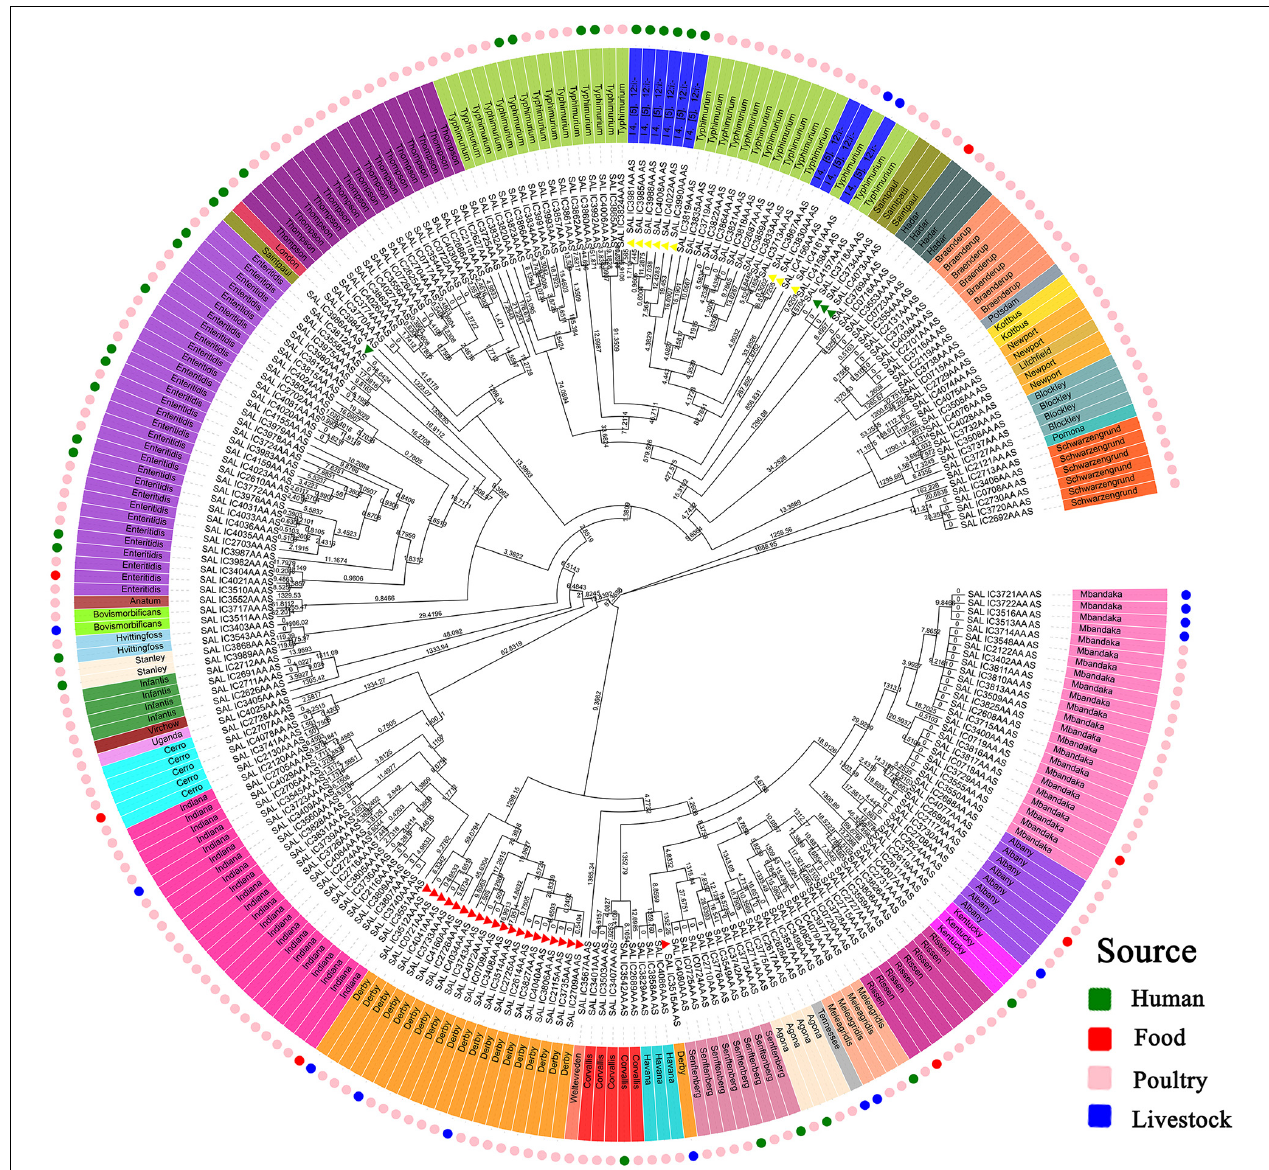
FIGURE 3 | Core genome MLST-based phylogenetic tree of S. enterica isolates. The neighbor-joining algorithm phylogenetic tree was created by EnteroBase based on cgMLST information and visualized using Evolview. The numbers stand for Branchlength values. The isolates’ serotypes are labeled in color, and most serovars forms serovar-specific clades except Saintpaul, Derby, and I 4,[5],12:i:-, which are signaled by the same color triangles. I 4,[5],12:i:- and Typhimurium may have a close genetic and evolutionary relationship. Further determination of the evolutionary relationship between the abovementioned serovars will be furtherly carried out. Different colors are used in the outermost ring to indicate the separation source to distinguish the specificities of different